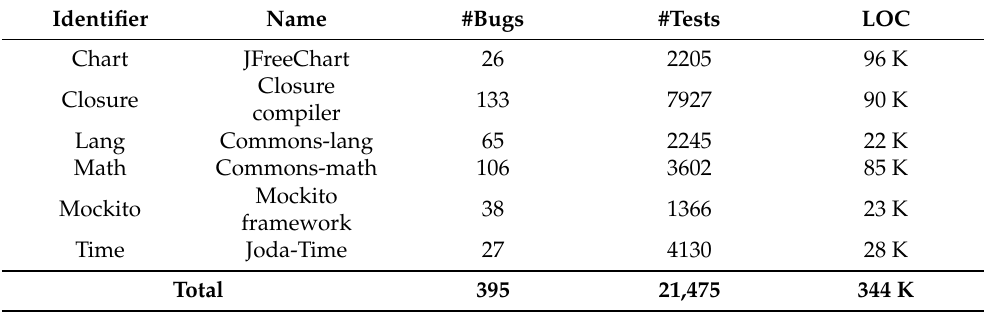
Table 1. Details of Defects4j.